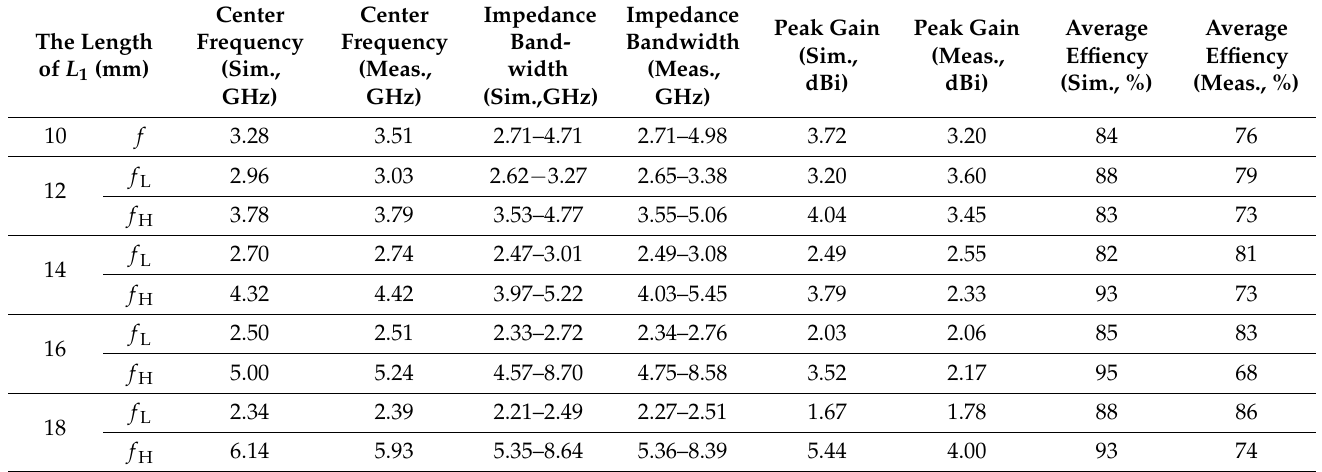
Table 2. The performances of the antenna (the initial condition: L 1 = L 2 = 10